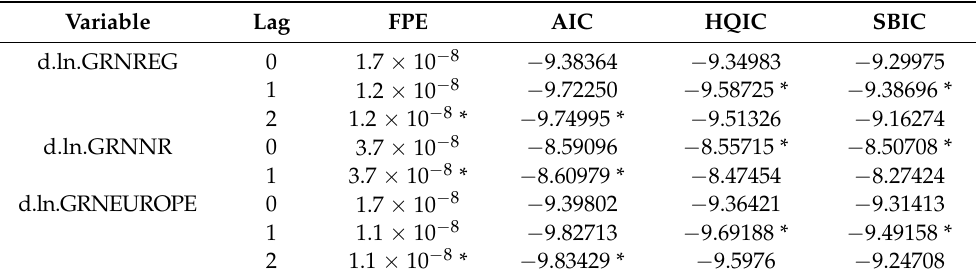
Table 4. Optimal lag length selection.